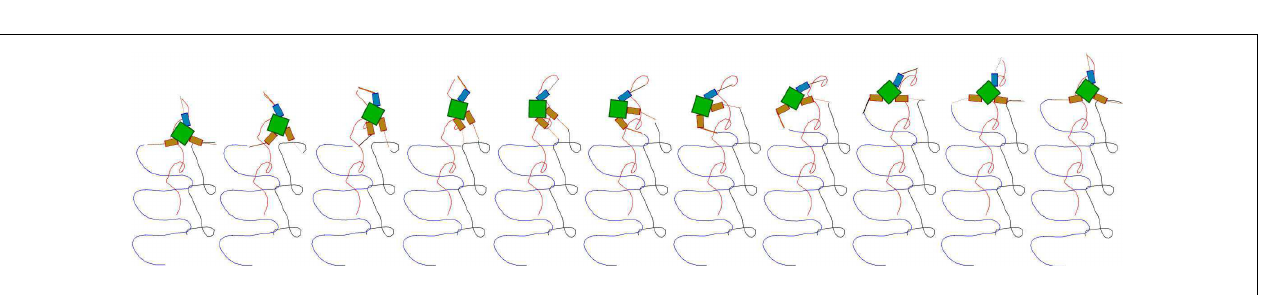
a trajectory which is very close to a straight line. Color coded fin tip traces (one color for each fin) are shown trailing the robot, indicating the regular, but fairly complex motion, of the